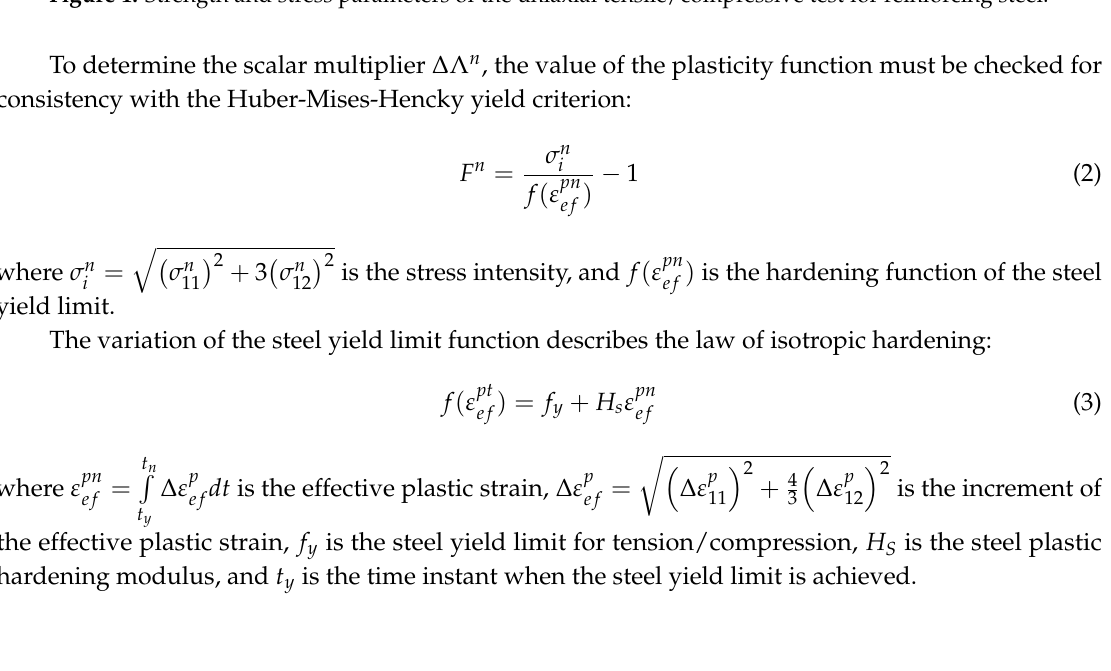
Figure 1. Strength and stress parameters of the uniaxial tensile/compressive test for reinforcing steel.